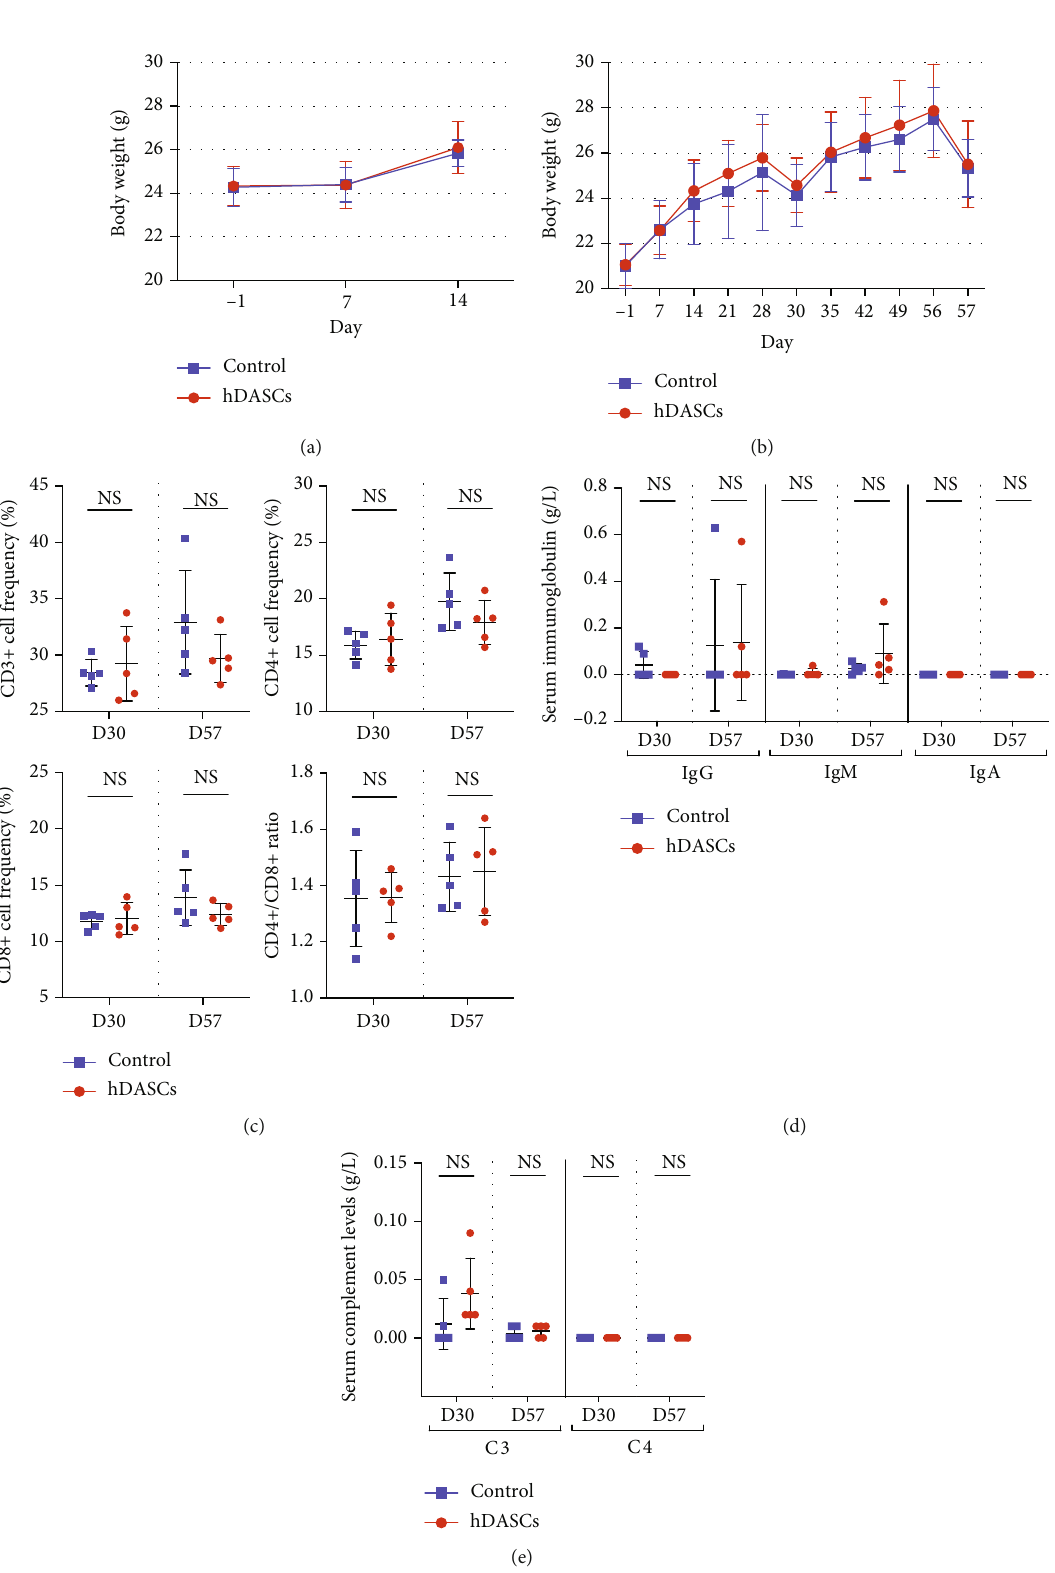
Figure 3: Safety evaluation of hDASC transplantation in mice. (a) Changes in mouse body weight at indicated days in short-term safety assay. n = 10 in each group. (b) Changes in body weight at indicated days in long-term safety assay. n = 20 in each group. (c) Quanti fi cation of lymphocyte subsets (CD3+, CD4+, and CD8+) and CD4+/CD8+ ratio on day 30 and day 57 in long-term safety assay. n = 5 in each group. (d, e) Quanti fi cation of serum immunoglobulin and serum complement levels on day 30 and day 57 in long-term safety assay. For each test, n = 5 in each